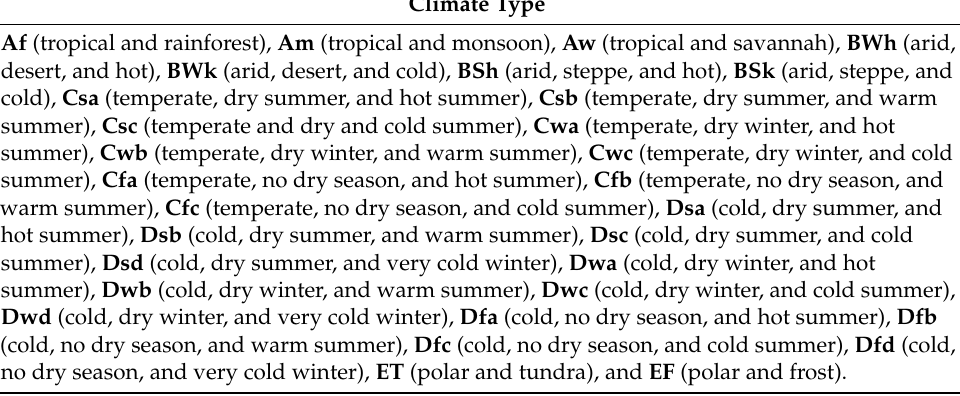
Table 2. Climate types according to Beck et al. [29] to determine diversity patterns among wild tomato accessions S. lycopersicum L. in